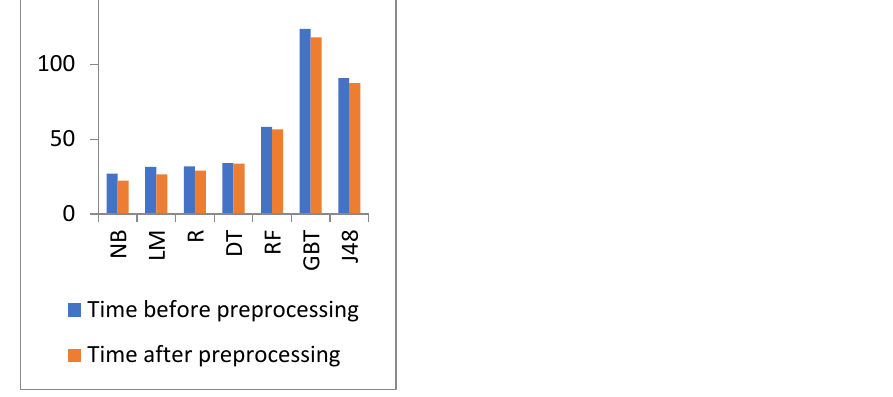
Figure 15. Time comparison of different algorithms on general health before and after prepro- cessing.